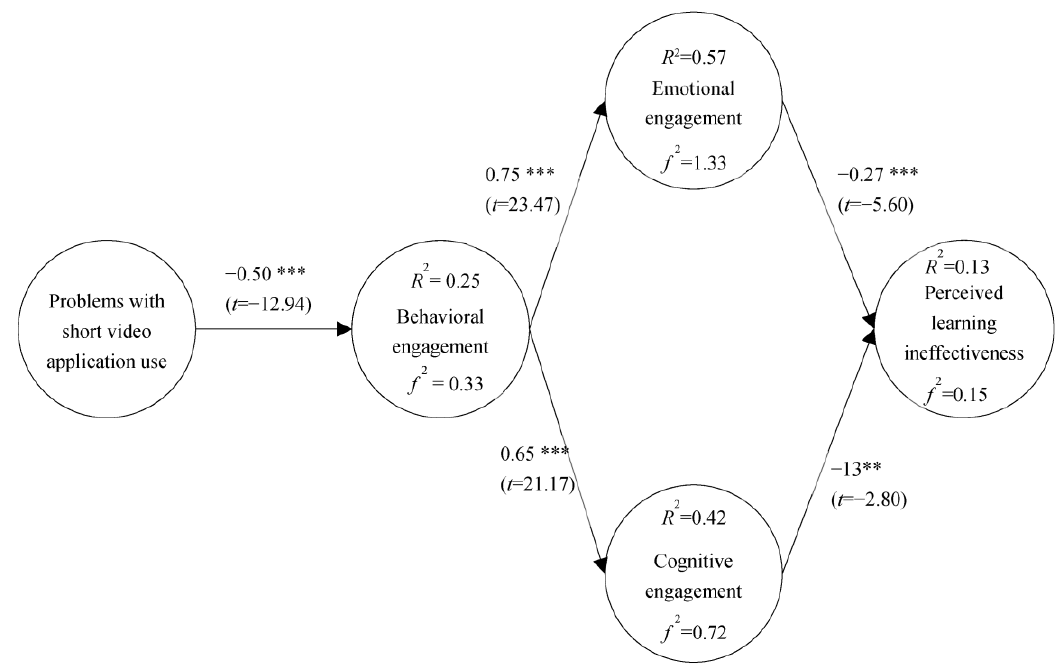
Figure 2. Research model verification. ** p < 0.01. *** p < 0.001.